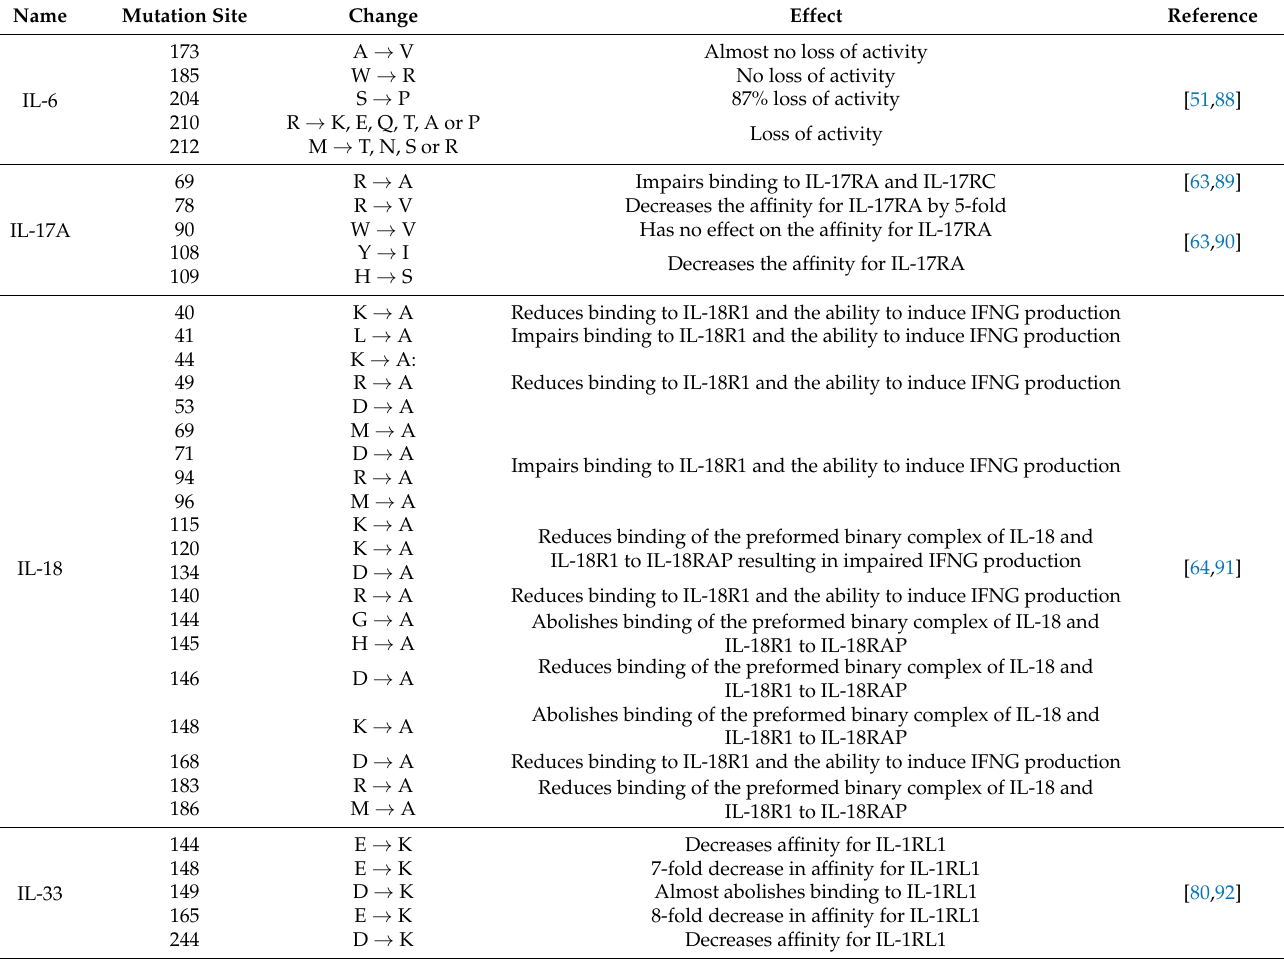
Table 2. Influence of mutations of selected interleukins on their